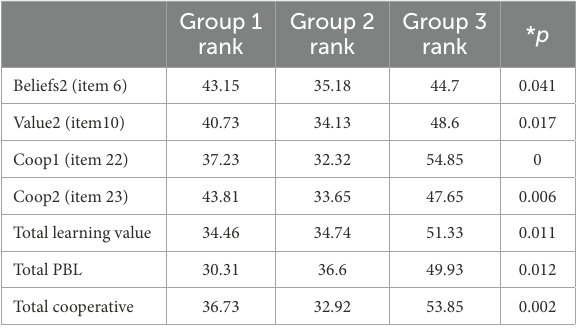
TABLE 5 Kruskal–Wallis analysis to evaluate how motivation depends on age.